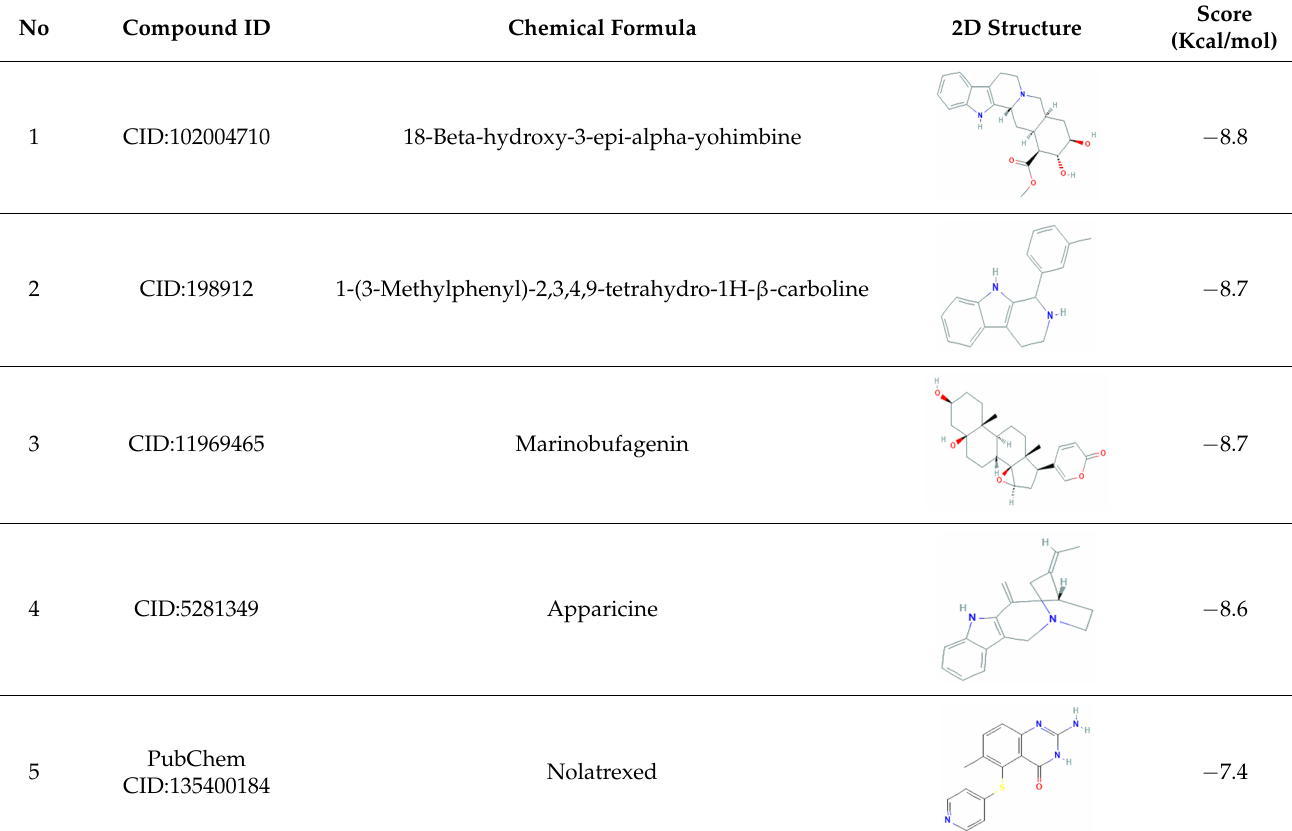
Table 1. List of compound identity, chemical name, and two-dimensional (2D) structure of selected best four ligands and nolatrexed (control).